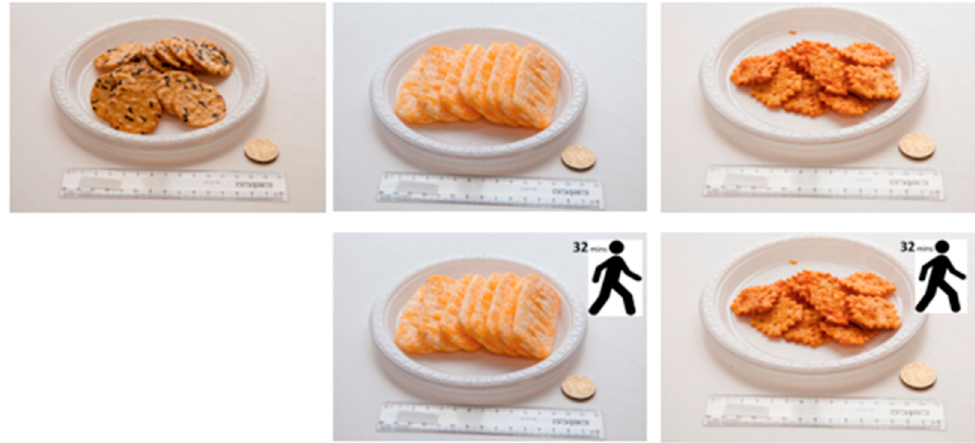
Figure 1. Examples of the snack foods (L-R: Sakata Seaweed Rice Cracker, Want Want Cheese Rice Cracker, Arnott’s Nacho Cheese Shapes) without and with the PACE label. Table 1. Samples and their corresponding blinding codes.